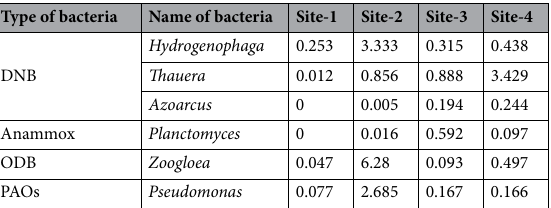
Table 3. Percentage of the functional microbes in the four sites (%) at the genus level. DNB, denitrifying bacteria; ODB, organic degrading bacteria; PAOs; phosphorus-accumulating bacteria.